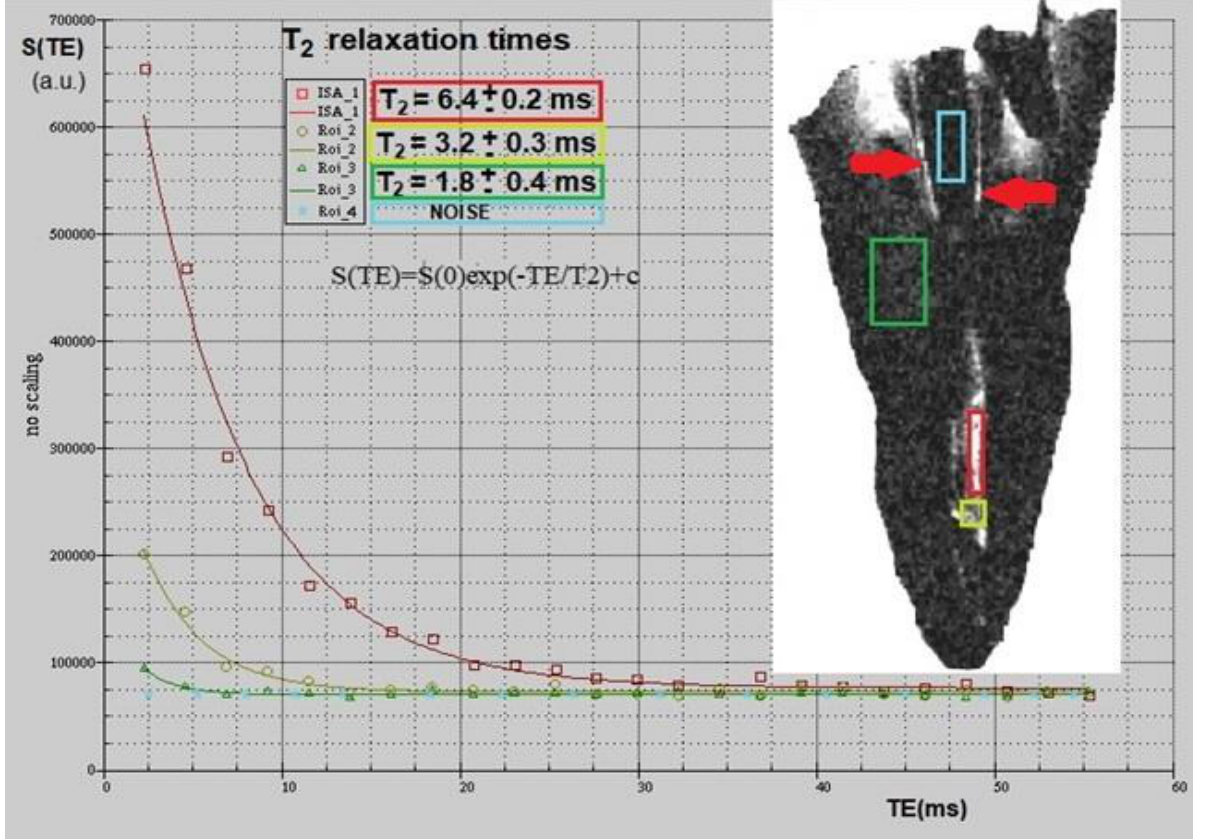
Figure 2. T2-weighted mMRI of tooth’s transverse section (white insert) with the different ROIs from which the data were extracted: light blue, Gutta-percha; green, dentine; red and yellow, voids and underfilled canals. The graph shows the experimental data decay vs. echo time (TE) in different tooth ROIs and the resulting fit function. From the fit of the function to data, T2 values were obtained in different regions of the tooth. Red arrows indicate spaces filled with water between dentine and Gutta-percha.